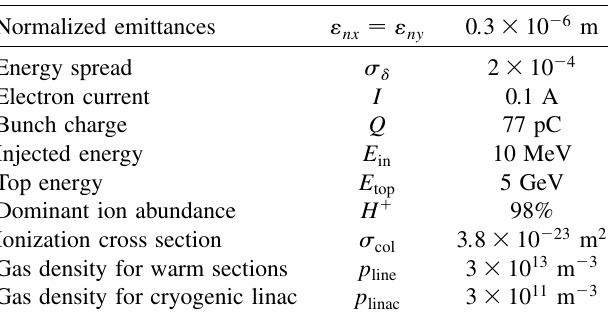
TABLE I. Parameters of the Cornell ERL used for the ex- amples in this paper.